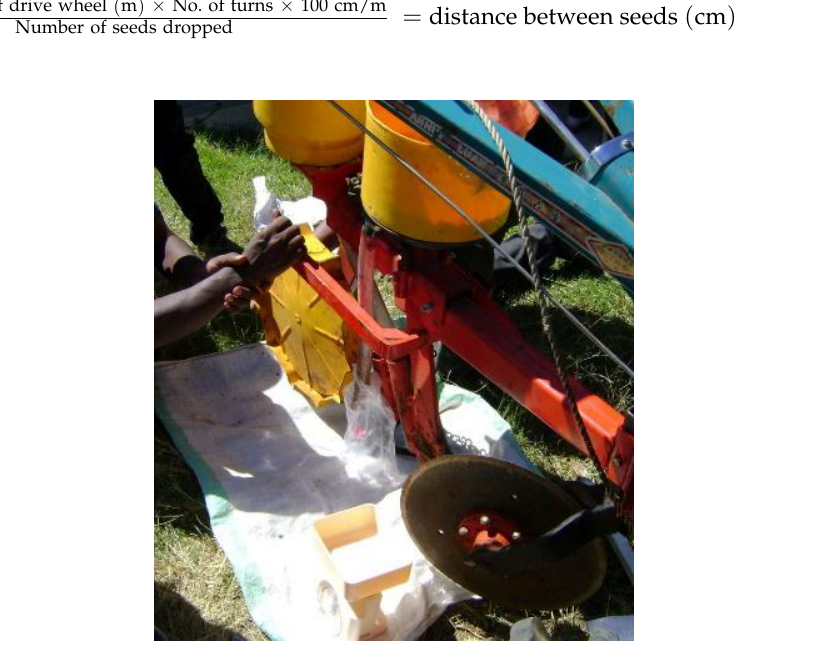
Figure 2. Calibration of a single-row no-till planter. The drive wheel is turned by hand and the seeds collected in a plastic bag attached to the seed outlet. Seeds can be counted and/or weighed to calculate seeding rates per ha.